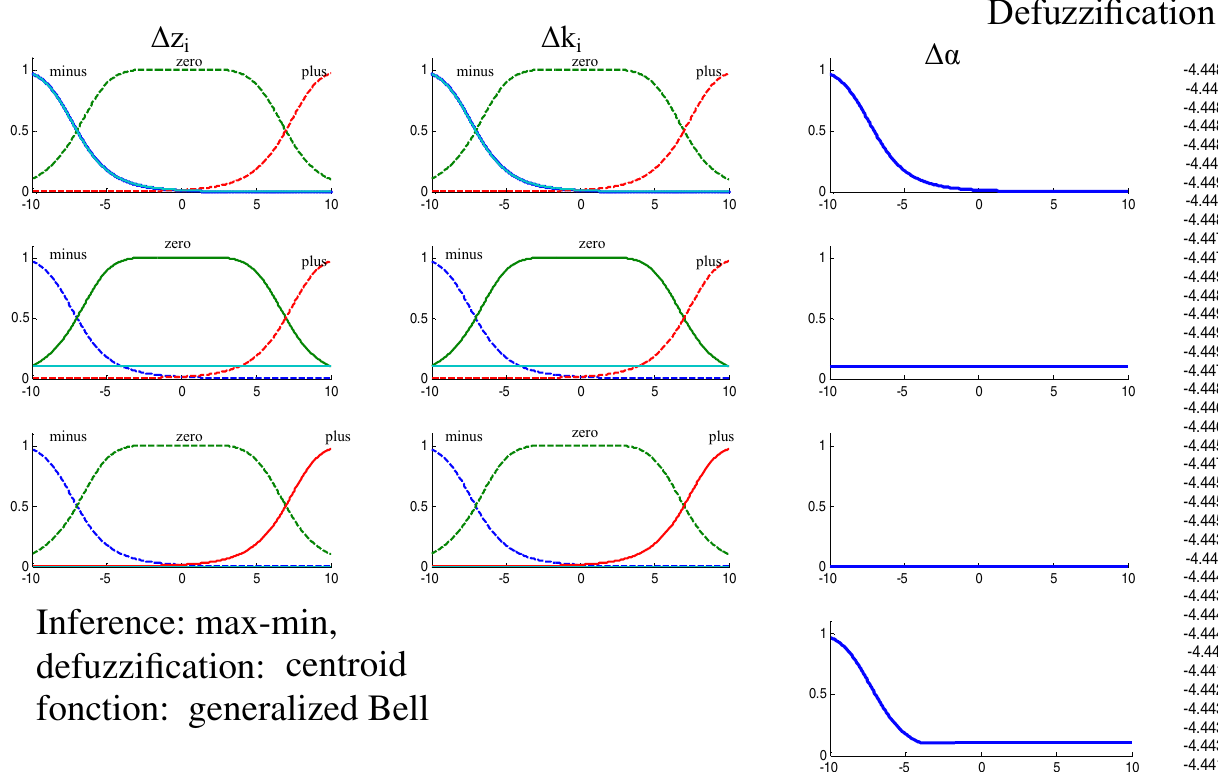
Fig. 5. (Color online) Screen printout of the premises, conclusions and rules and its graphical representation for the Δα i